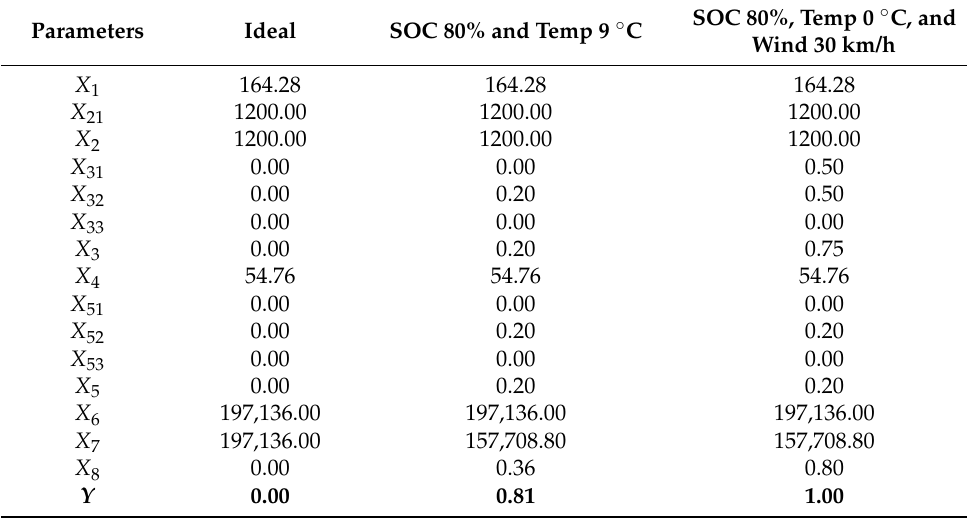
Table 5. Determination of the Y parameter regarding the 3 C-rates.